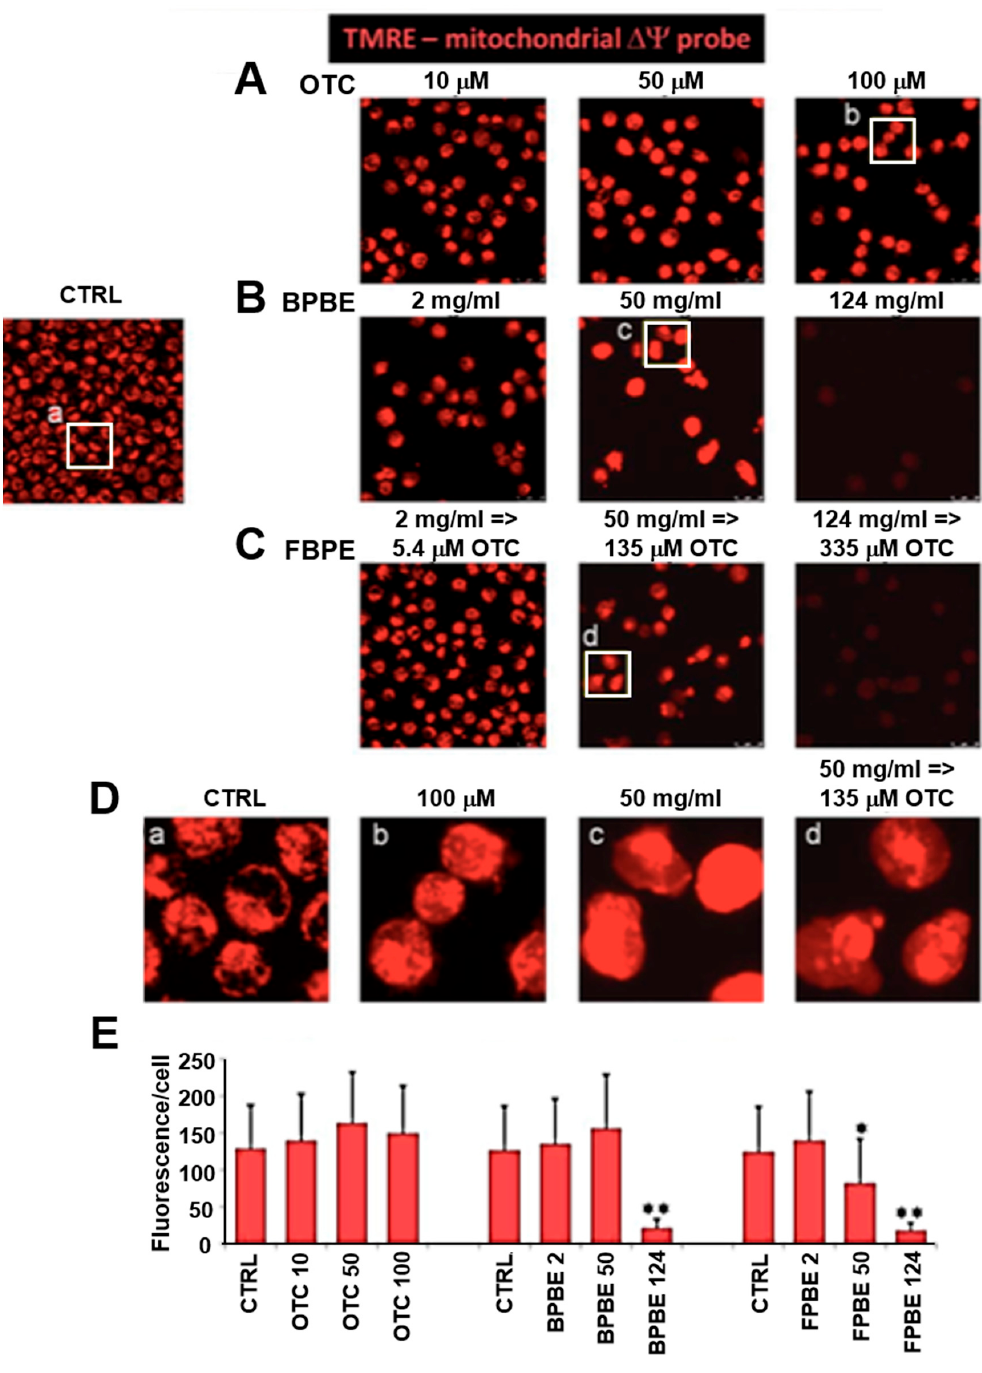
Figure 4. E ff ect of chicken bone powder treatment on the mitochondrial membrane potential in K562 cells. Cells were treated for 48 h with the indicated concentrations of either of OTC ( A ), BPBE ( B ), FPBE ( C ), and then incubated with tetramethylrhodamine, ethyl ester (TMRE) and subjected to confocal microscopy analysis as detailed under Materials and Methods; untreated cells were used as control (CTRL). The images shown are from a single experiment and are representative of three independent experiments yielding similar results; ( D ) digital magnification of selected areas shown as white frames. ( E ) Quantification of the fluorescence-related pixel intensity / cell; for each condition and for each experiment 10–15 di ff erent optical fields were randomly chosen, and the fluorescence intensity / cell averaged ± SEM; * p < 0.05, ** p < 0.01 with respect CTRL